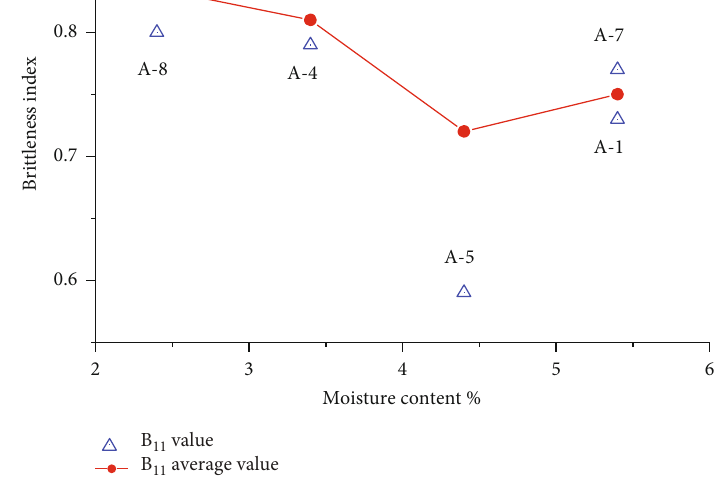
Figure 10: B under di ff erent water content. 11